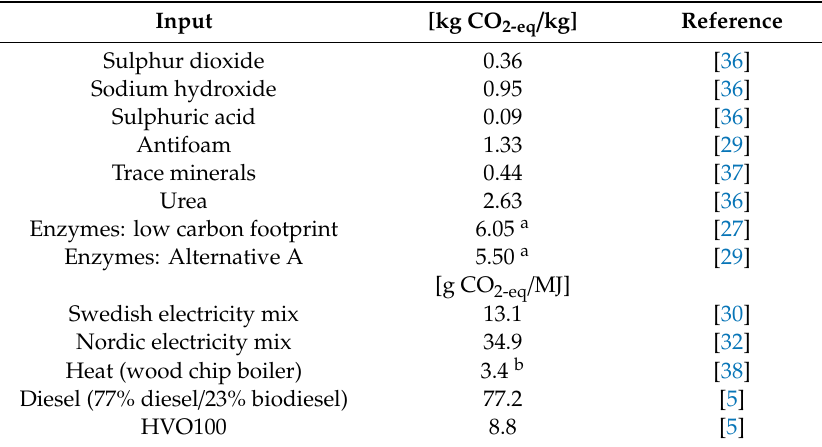
Table 2. Input of chemicals, nutrients and enzymes in the production